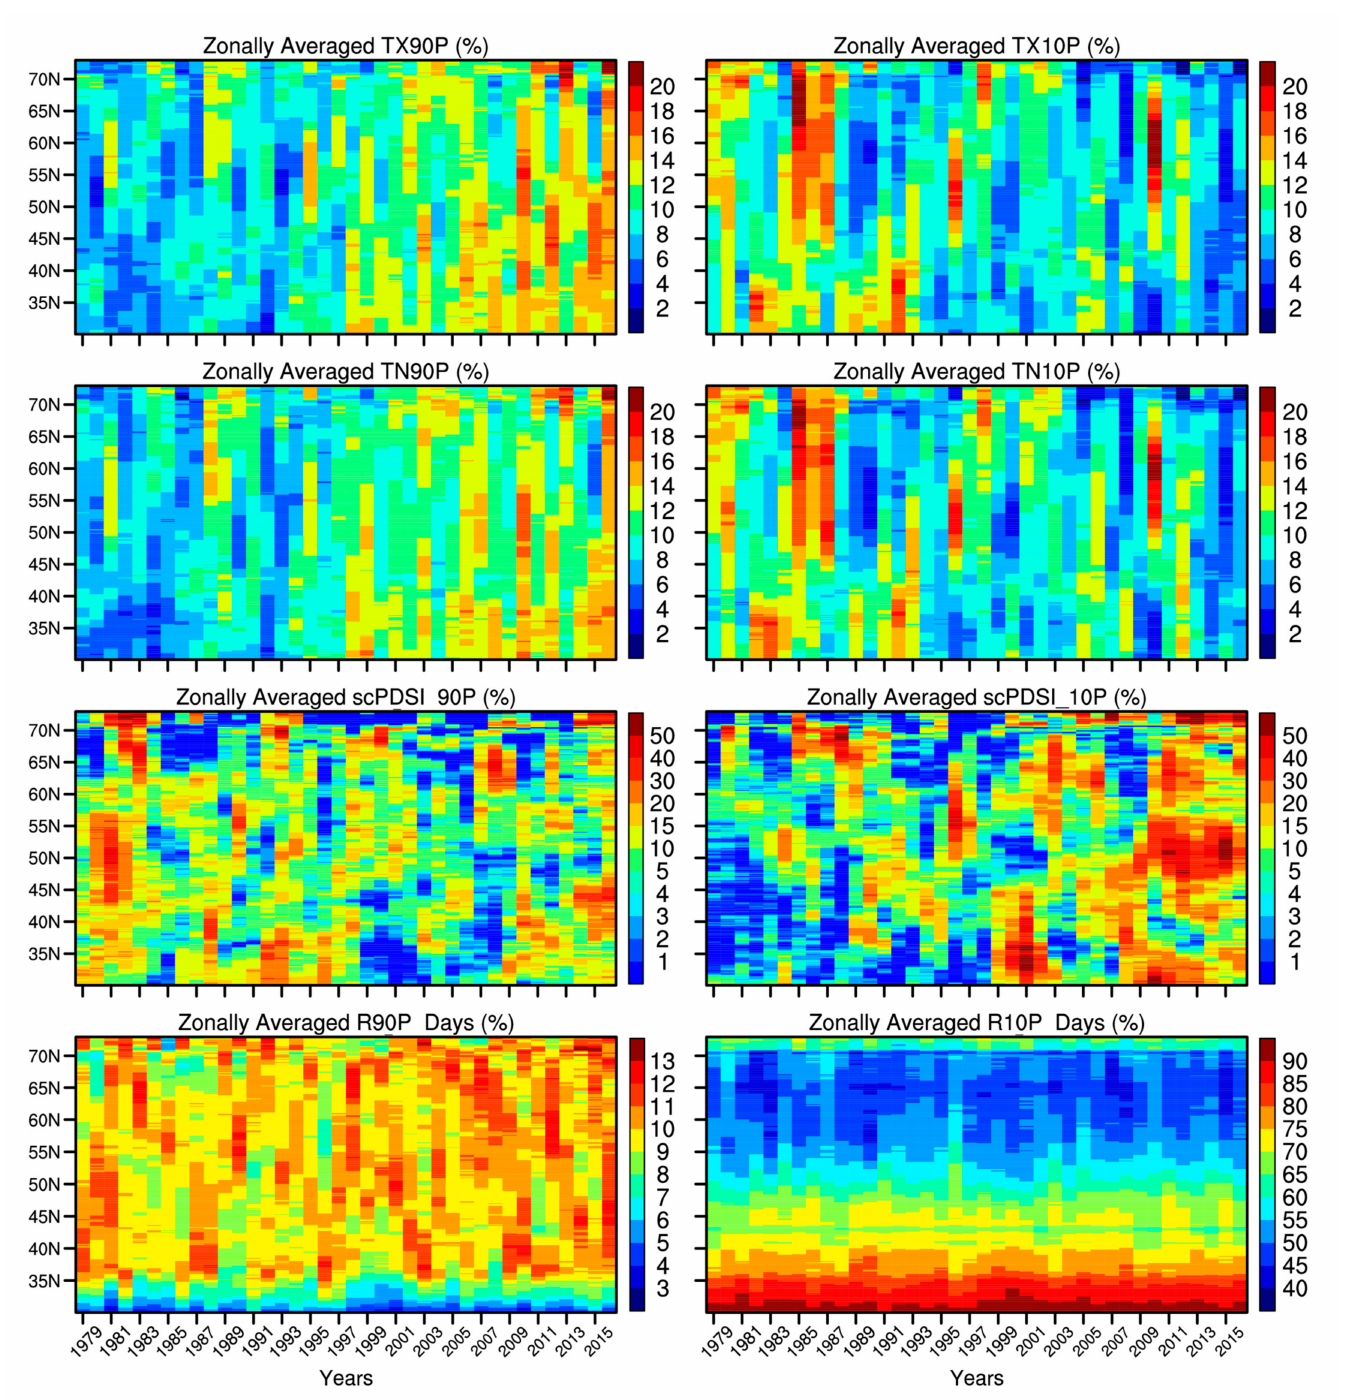
Figure 6. Zonal average of the extreme indexes over the EURO–MED